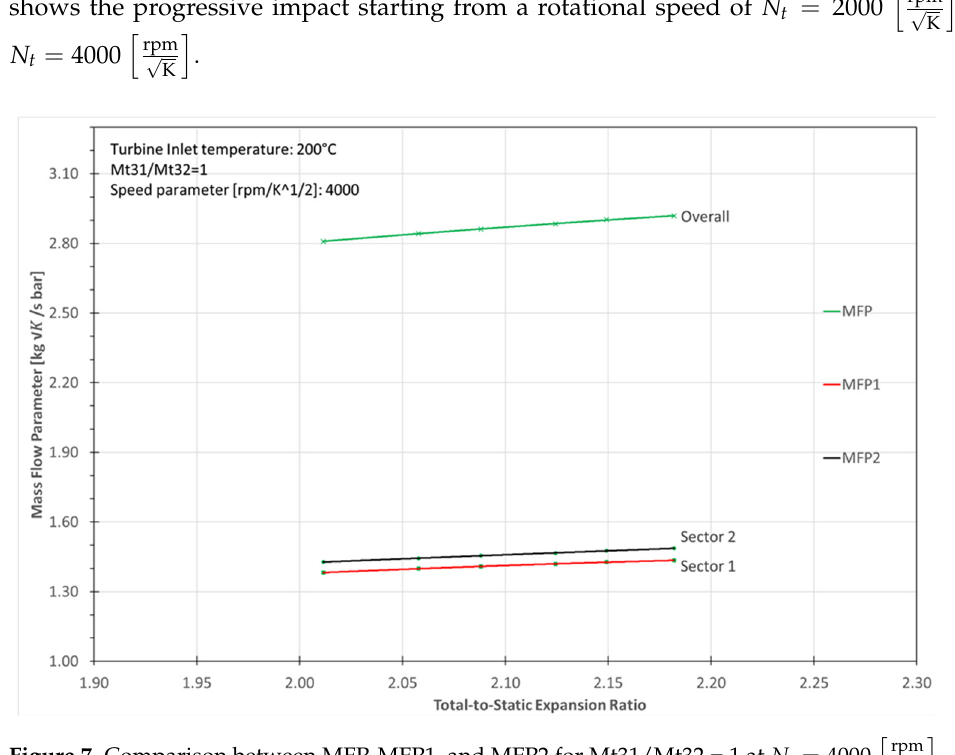
Figure 7. Comparison between MFP, MFP1, and MFP2 for Mt31/Mt32 = 1 at (cid:1840) (cid:3047) = 4000 (cid:4674) (cid:2928)(cid:2926)(cid:2923)